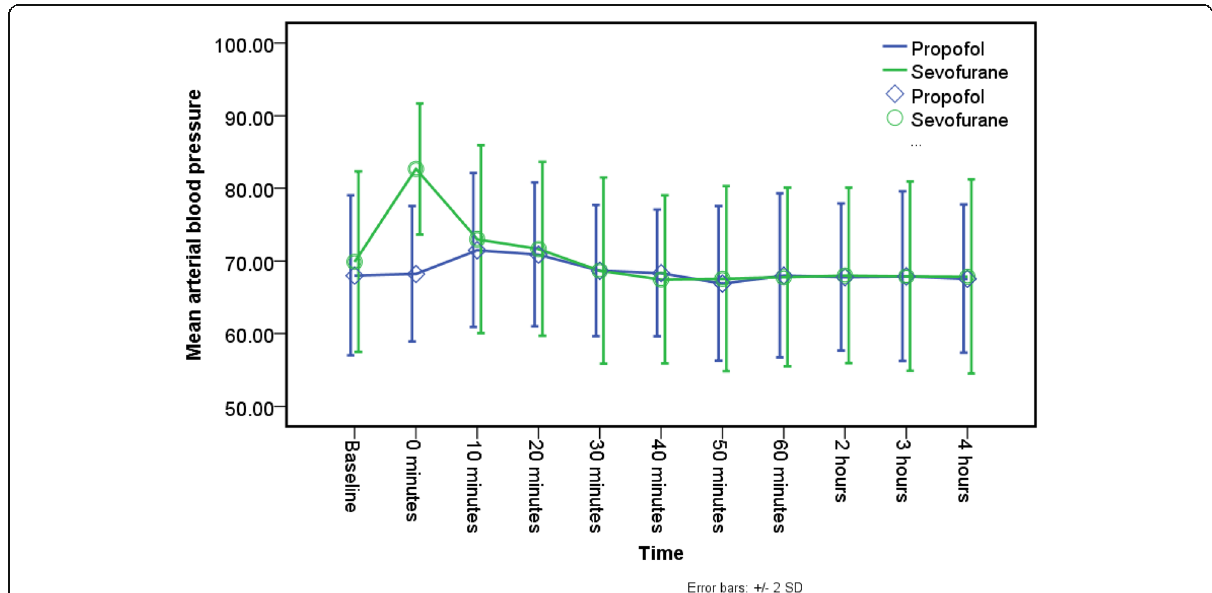
Fig. 3 Changes in mean arterial pressure from baseline up to 4 h in the two studied groups. A P value < 0.05 was considered